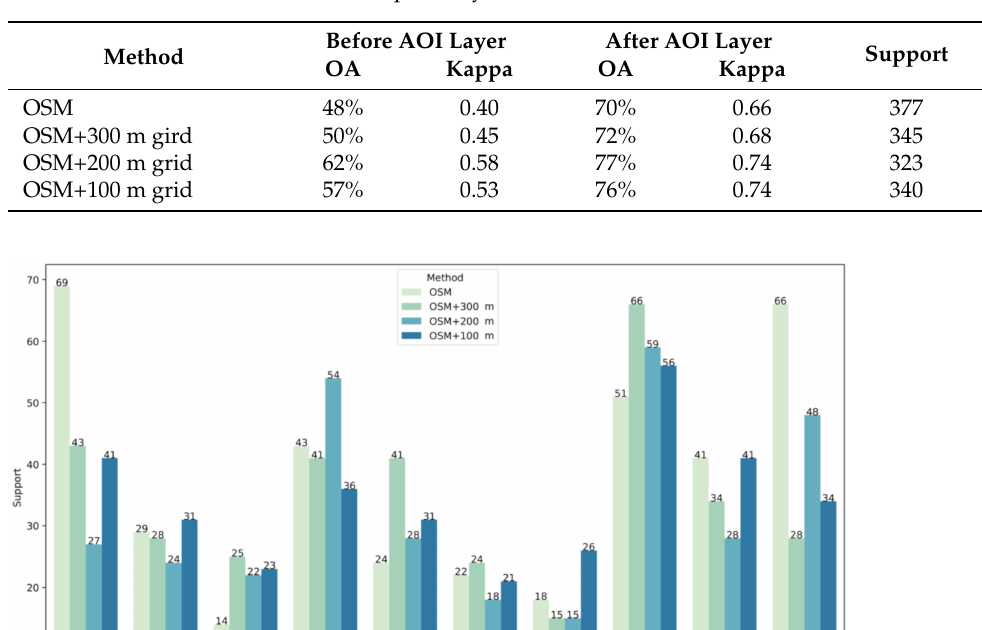
Figure 11. Map of EULUC-AOI (OSM+100 m grid) in Beijing, 2019. Table 5. Accuracy assessment. OA, Kappa, and Support donate overall accuracy, Kappa coefficients, and the number of validation units, respectively.